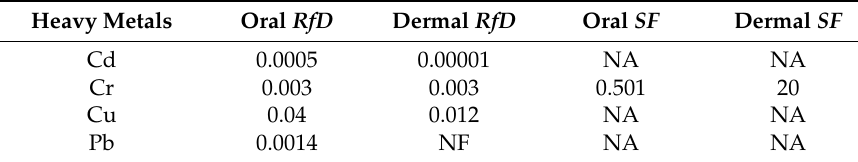
Table 2. Summary of RfD and SF of